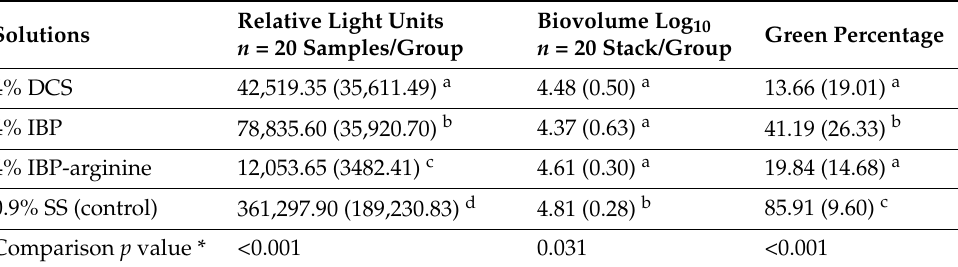
Table 1. Antimicrobial activity of solutions on polymicrobial biofilms. Relative light units (RLUs), Log 10 biovolume ( µ m 3 ), and green percentage. Mean ± standard deviation (SD).